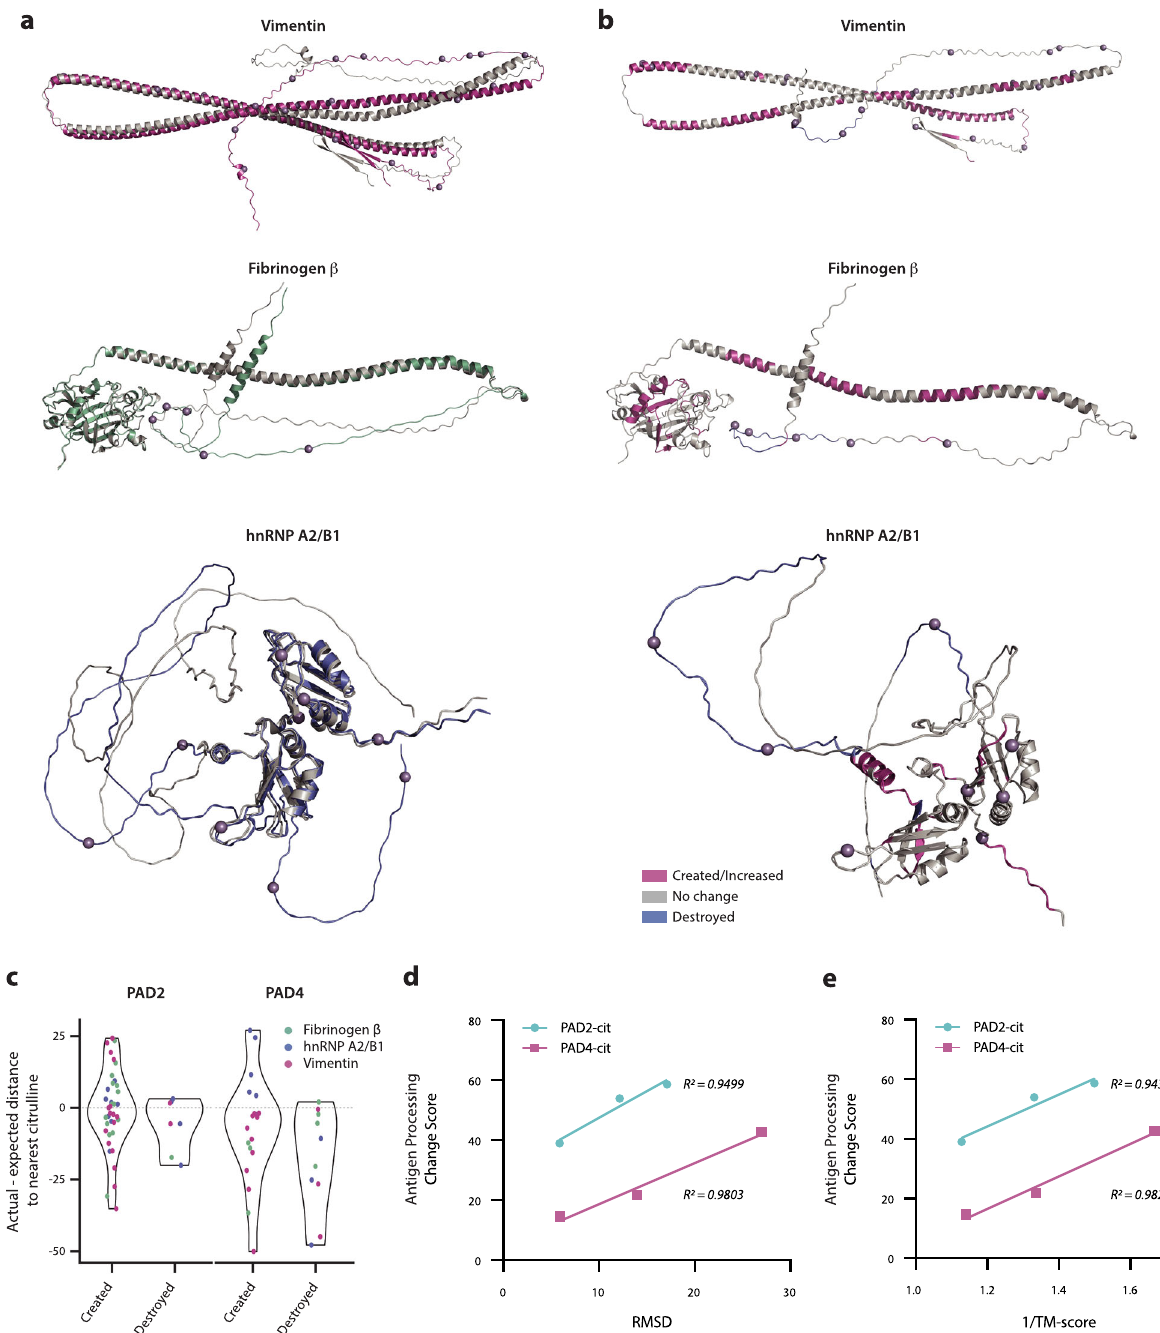
Fig. 3 | Citrullination impacts protein dynamics by promoting the destabili- zationofproteinfolding.a PyMOLstructuralalignmentofnative(gray)andPAD2/ 4-combined citrullinated (colored by antigen) PDB structures predicted by Alpha- FoldAIsystem,excluding fi brinogen α chainduetocomputationalconstraints.Mass spectrometry-con fi rmed citrullination sites from PAD2 and PAD4 combined are denoted as purple spheres on the citrullinated structure. b Predicted PAD2- citrullinated structures with signi fi cantly changed regions color-coded according to